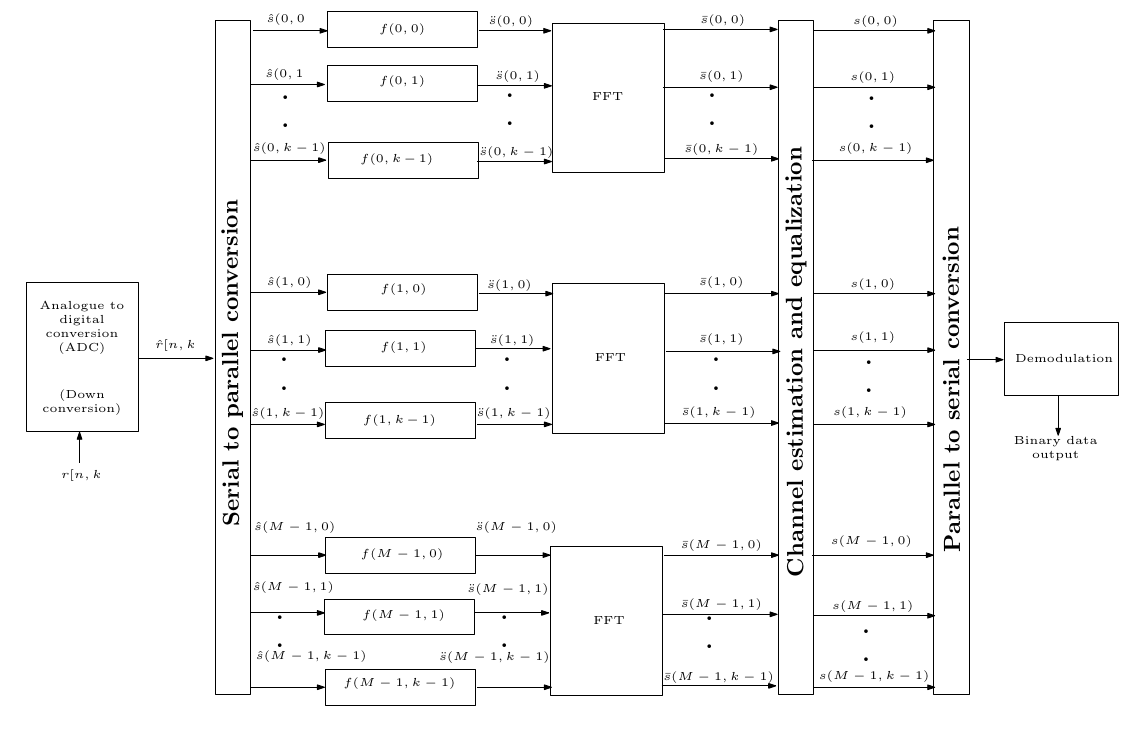
Figure 11. Receiver structure of UFMC system.